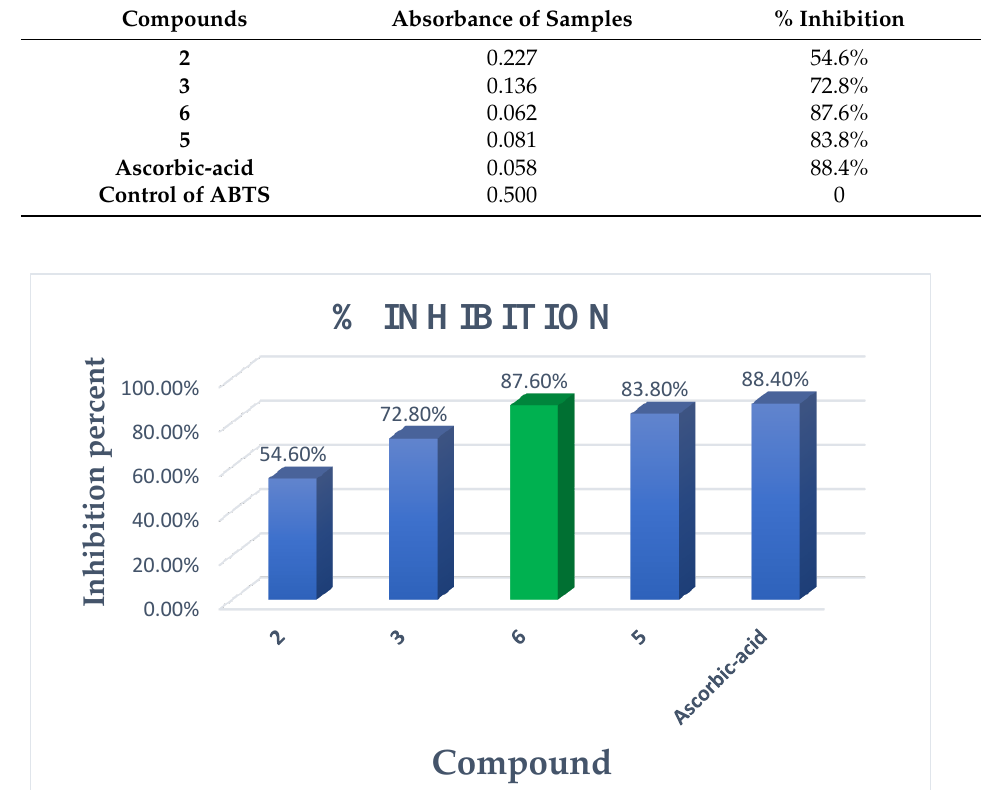
Figure 2. Antioxidant activity screening assay.